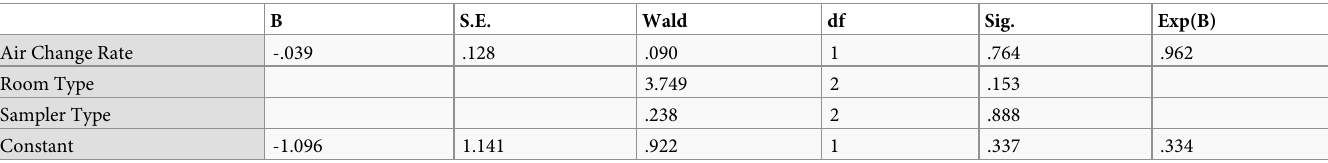
Table 5. Logistic regression results showing likelihood of positive RNA by air exchange rate, room type, and sample type. B S.E. Wald df Sig.